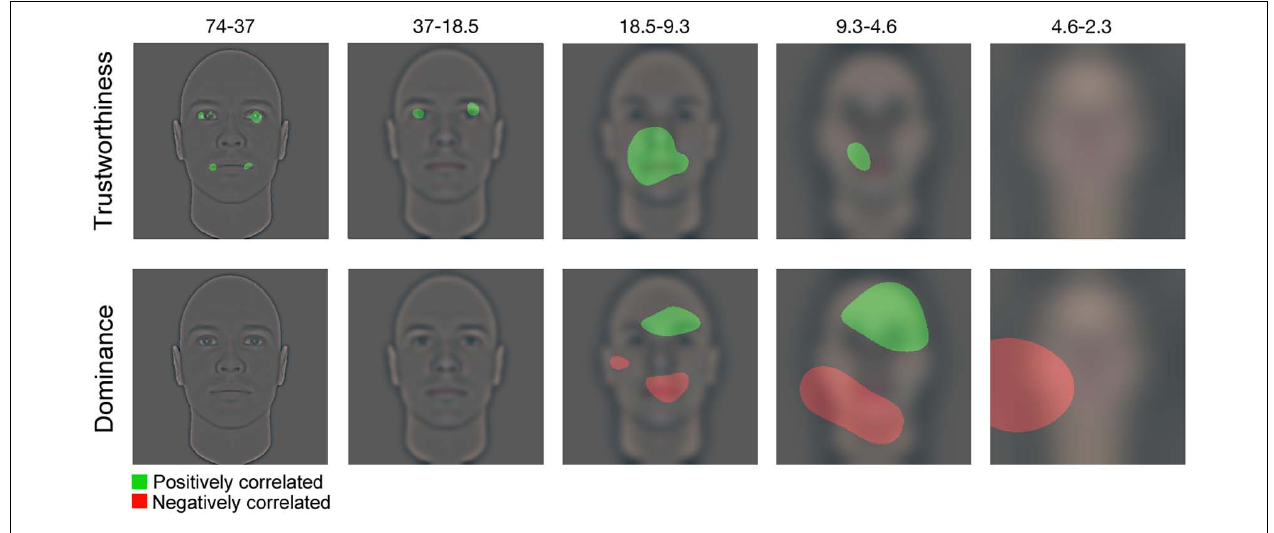
FIGURE 2 | Significant pixels for each spatial-frequency bandwidth (from fine to coarse) are displayed.